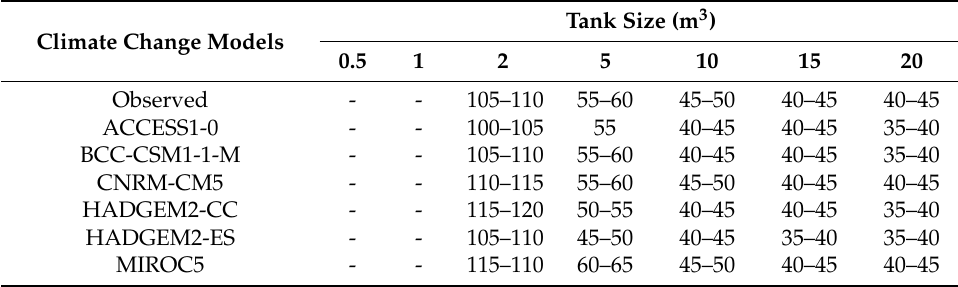
Figure 15. Change in reliability for DJF 2060–2090 period for 5 m 3.